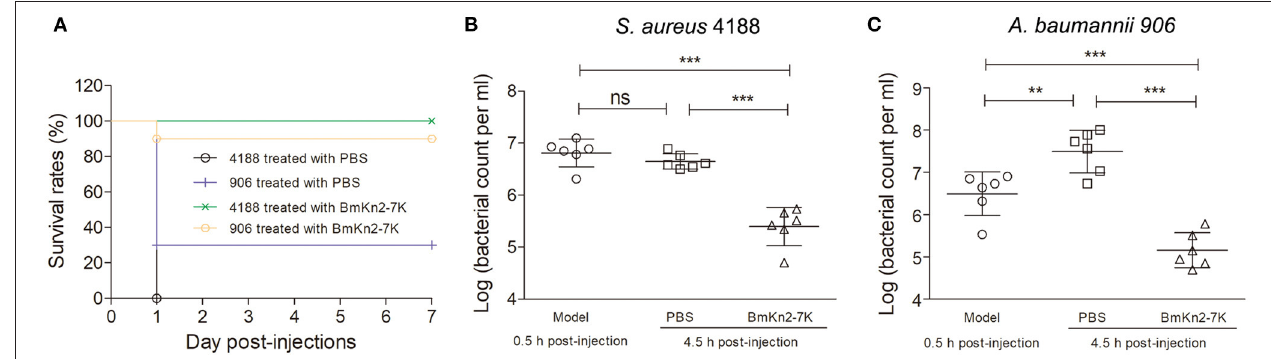
FIGURE 6 | In vivo antimicrobial efficacy of BmKn2-7K. (A) Survival curves of infected mice after treatment with BmKn2-7K. Each cohort of ICR mice ( n = 10) was infected with 5 × 10 7 cfu of S. aureus 4188 (or 6.25 × 10 7 cfu of A. baumannii 906) and cultured for 0.5h to establish the lethal peritoneal infection model. Drug treatments were performed with a single dose of 20 (or 25) mg kg − 1 body weight BmKn2-7K for the S. aureus 4188 (or A. baumannii 906) infected model, respectively. (B) Quantitative determination of bacterial loads in the peritoneal fluid of S. aureus infected ICR mice ( n = 6). (C) Quantitative determination of bacterial loads in the peritoneal fluid of A. baumannii infected ICR mice ( n = 6). The logarithm value of the number of viable bacteria from each mouse was plotted as individual dots, error bars represent the standard deviation from the mean within each cohort, ** P < 0.01; and *** P < 0.001; ns represents “no significance.” The